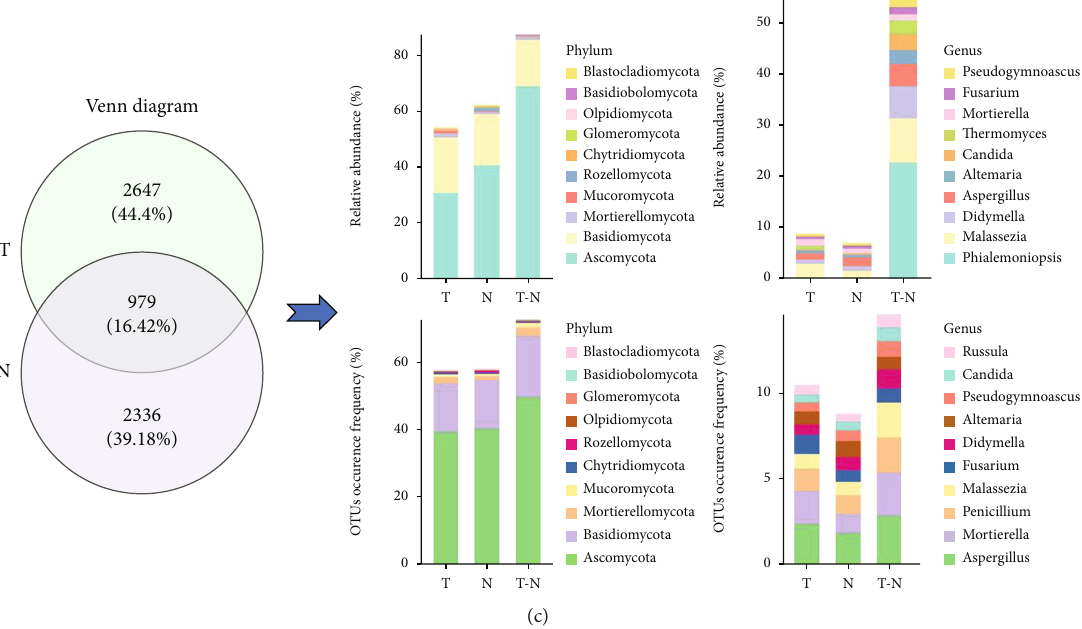
Figure 1: Alteration of gastric mucosal fungal microbiota between the tumor and normal group. (a) Krona pie charts were established to indicate the distribution of gastric mucosal fungal microbiomes in the stomach microenvironment; (b) alpha rarefaction curves were used to estimate the species richness of the fungal microbiota between the two groups; (c) the Venn diagram illustrated the overlapping gastric mucosal fungal microbiota between the two groups, and the distribution and abundance of overlapping fungi was evaluated based on the sequence information of the OTUs at the phylum and genus least squares discriminant analysis (OPLS-DA) were used to indicate microbial composition di ff erences between samples.